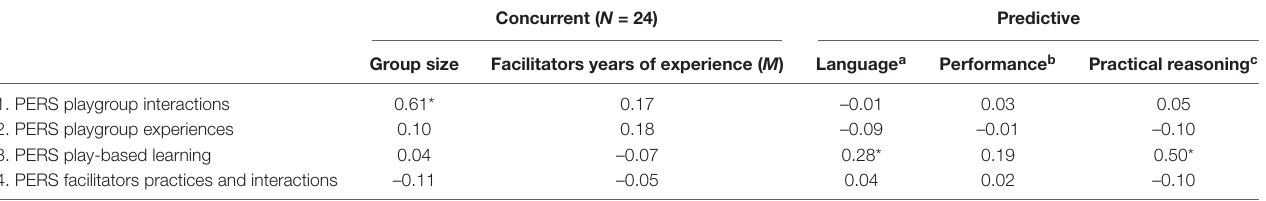
TABLE 9 | Bivariate correlations for the criterion-related validity of PERS